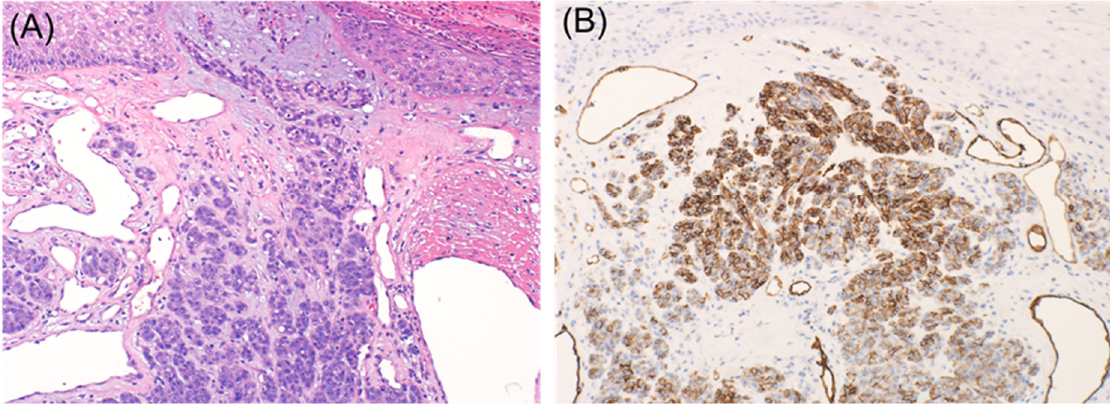
Figure 5. Malignant melanoma ( A , H & E 10) with aberrant expression of CD31 ( B , immunohistochemical stain 10).